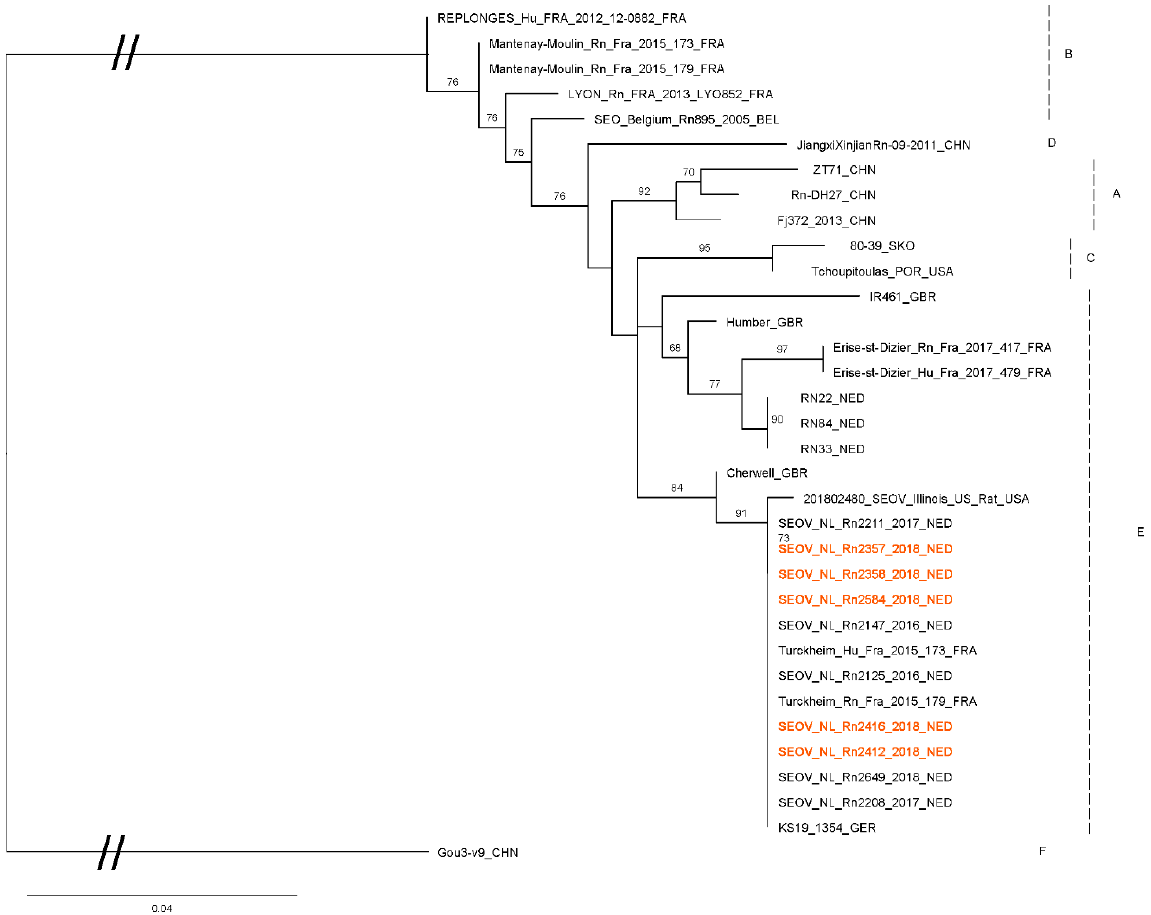
Figure 2. Maximum likelihood phylogenetic tree for SEOV partial S segment (274nt) sequences. Sequences from this study are shown in red (Genbank accession numbers MT993920-MT993924). The quality of the sequences from the two positive rattery rats was too low to include in this comparison. Numbers along branches are bootstrap values, only bootstrap sup- port of >70% are shown. Scale bar indicates nucleotide substitutions per site. Letters behind branches refer to groups of SEOV sequences as described by Kim et al. [23]. At the end of the strain names the country of origin is given: BEL, Belgium; CHN, China; FRA, France; GBR, Great Britain; GER, Germany; SKO, South Korea; NED, The Netherlands; and USA, United States.